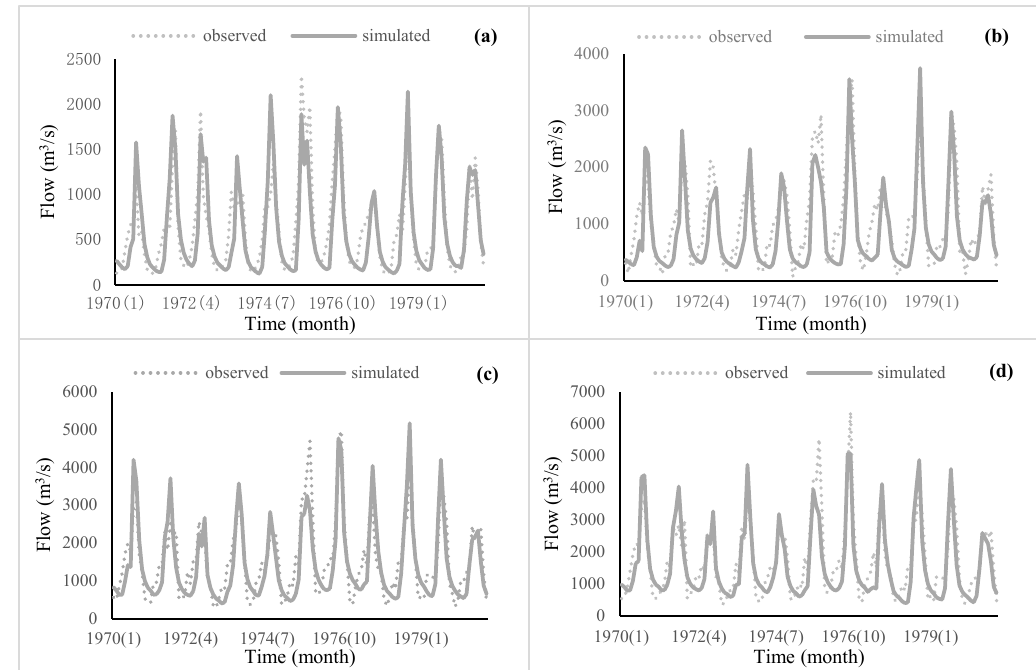
Figure 4. Monthly flow observation and simulation values of Tangnaihai ( a ), Toudaoguai ( b ), Sanmenxia ( c ) and Lijin ( d ) during calibration period (1970–1980).